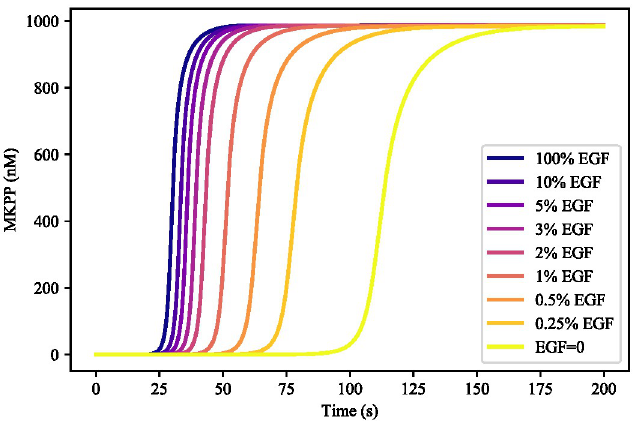
Fig 18. Effect of different levels of EGF concentration on MKPP in the composed EGFR-Ras-MAPK bond graph model. The concentration of EGF was set to 0 , 0.25% , 0.5% , 1% , 2% , 3% , 5% , 10% , and 100% of its initial concentration (680 nM). The behaviour of MKPP changes by altering the initial concentration of